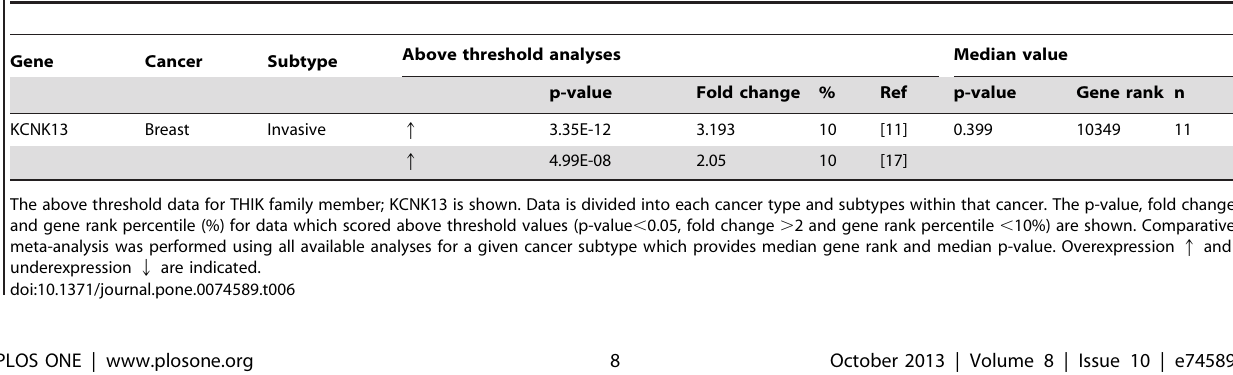
Table 6. THIK family member, KCNK13 expression in